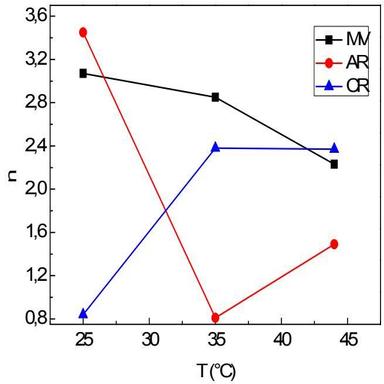
Influence of temperature on the parameter n for the dye adsorption on activated carbon CMCAC at 25–45 ◦C.